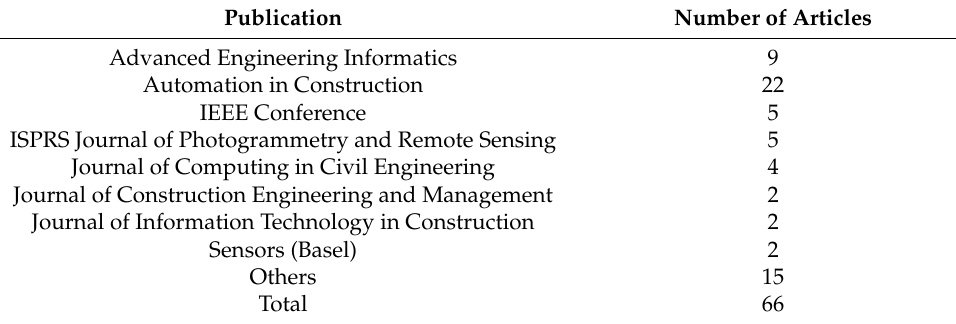
Table 1. Literature sources.